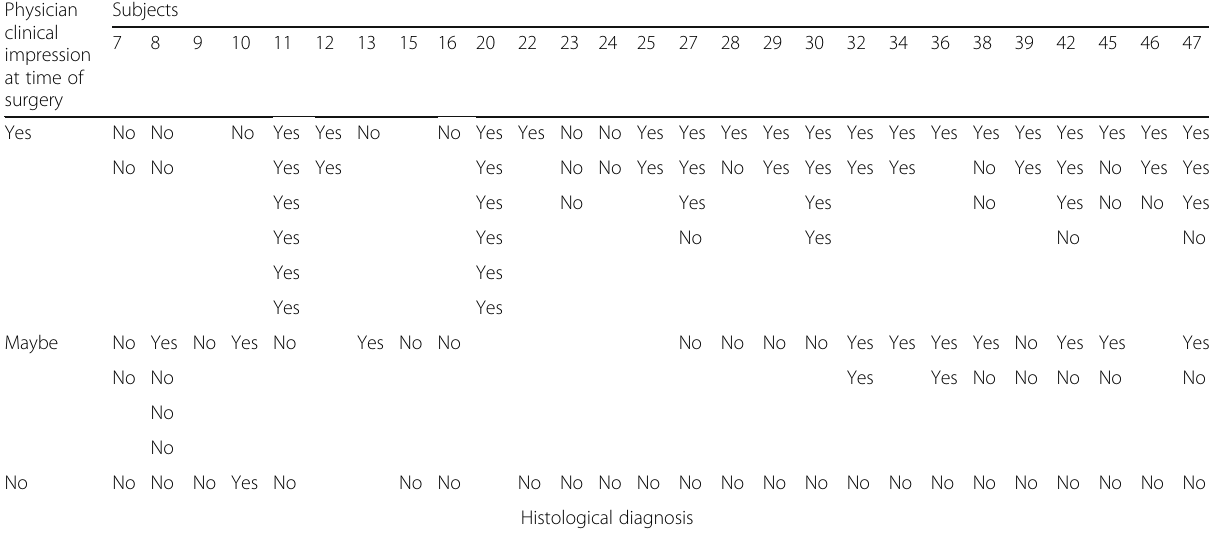
Table 2 Clinical Impression vs. Histology Gold Standard Physician clinical impression at time of